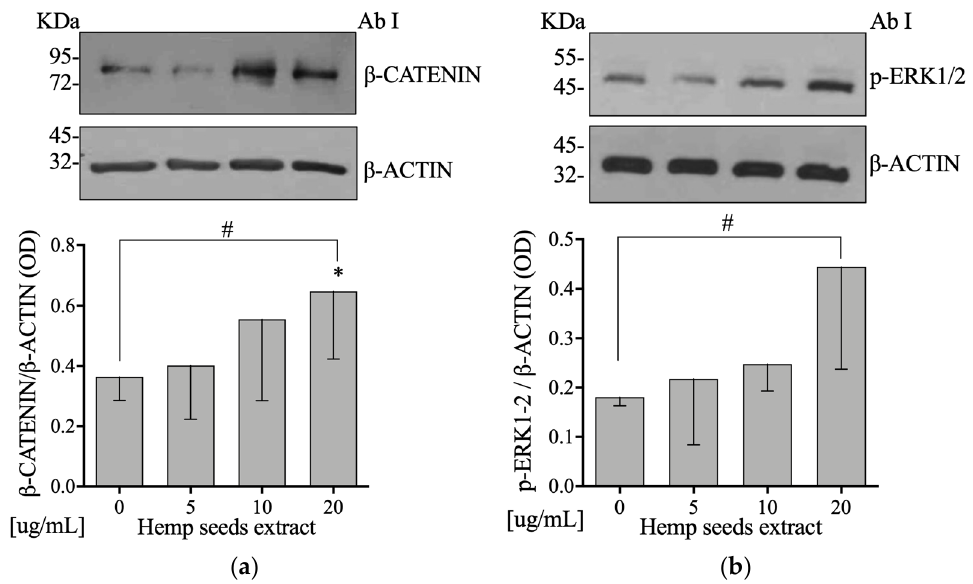
Figure 2. Hemp seed extract increases β -catenin and p-ERK1/2 pathways protein levels on Saos-2 cells. ( a ) Semi-confluent cultures of human osteoblast-like cells (Saos-2) incubated with HSE 5, 10, or 20 µg/mL for 24 hours. Cell proteins were analyzed by Western blotting with antibodies specific to β -catenin and β -actin. ( b ) Semi-confluent cultures of human osteoblast-like cells (Saos-2) were incubated with HSE 5, 10, or 20 µg/mL for 10 min. Cell proteins were analyzed by Western blotting with antibodies specific to phosphorylated ERK1/2 and β -actin. Data are represented as mean ± SD. Statistical analysis: Student’s t-test vs. 0 * p < 0.05, Linear regression # p < 0.05.